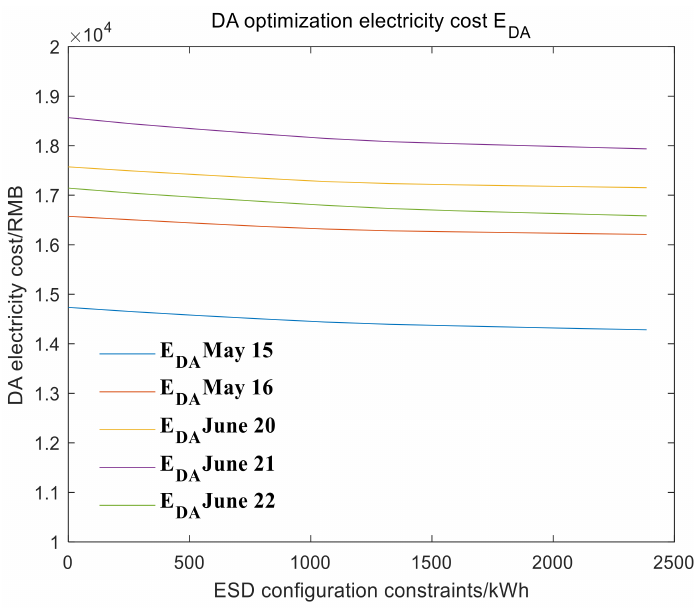
Figure 8. DA electricity cost optimization